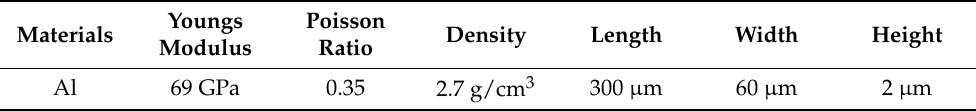
Table 1. Parameters of the cantilever beam.